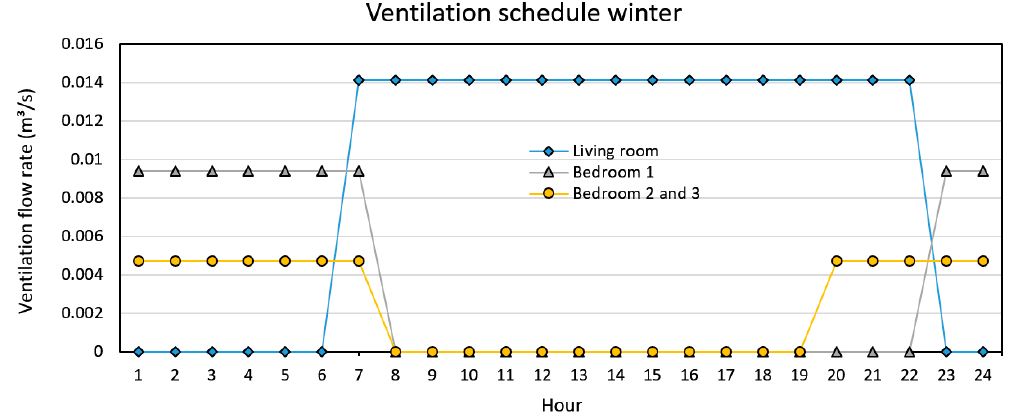
Figure 28. The ventilation schedule of each room during winter.